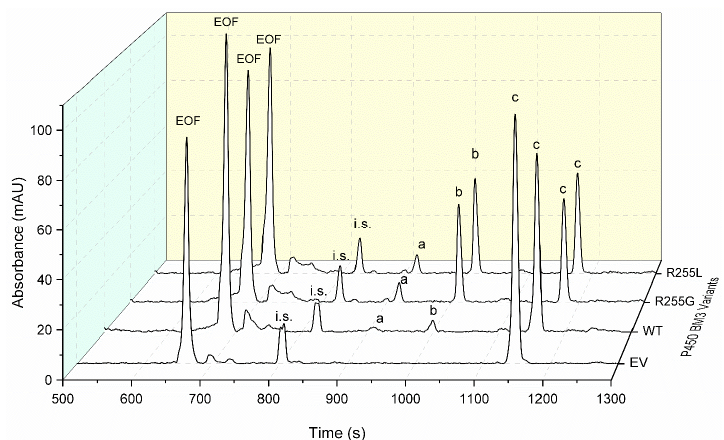
Figure A8. Product analysis via CE after conversion of benzo-1,4-dioxane with lysate from EV (negative control), P450 BM3 WT, and variants R255G and R255L. The data was obtained from 4 h conversion reactions employing GDH for efficient NADPH cofactor regeneration. EOF—electro-osmotic flow; i.s.—internal standard (benzyl alcohol); a—2,3-dihydrobenzo-1,4-dioxin-6-ol; b—2,3-dihydrobenzo-1,4-dioxin-5-ol; c—benzo-1,4-dioxane.